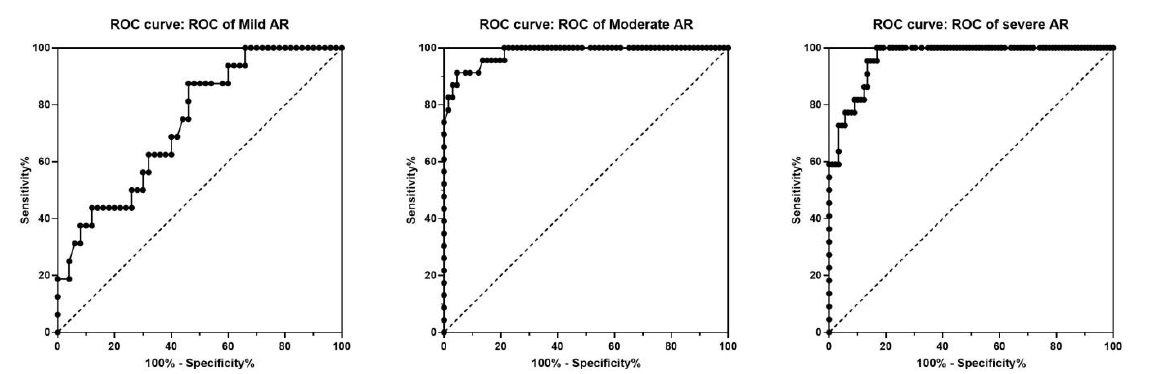
Figure (2): Receiver Operating Characteristic Curve (ROC) curve analysis to predict the GLS validity to discriminate the degree of